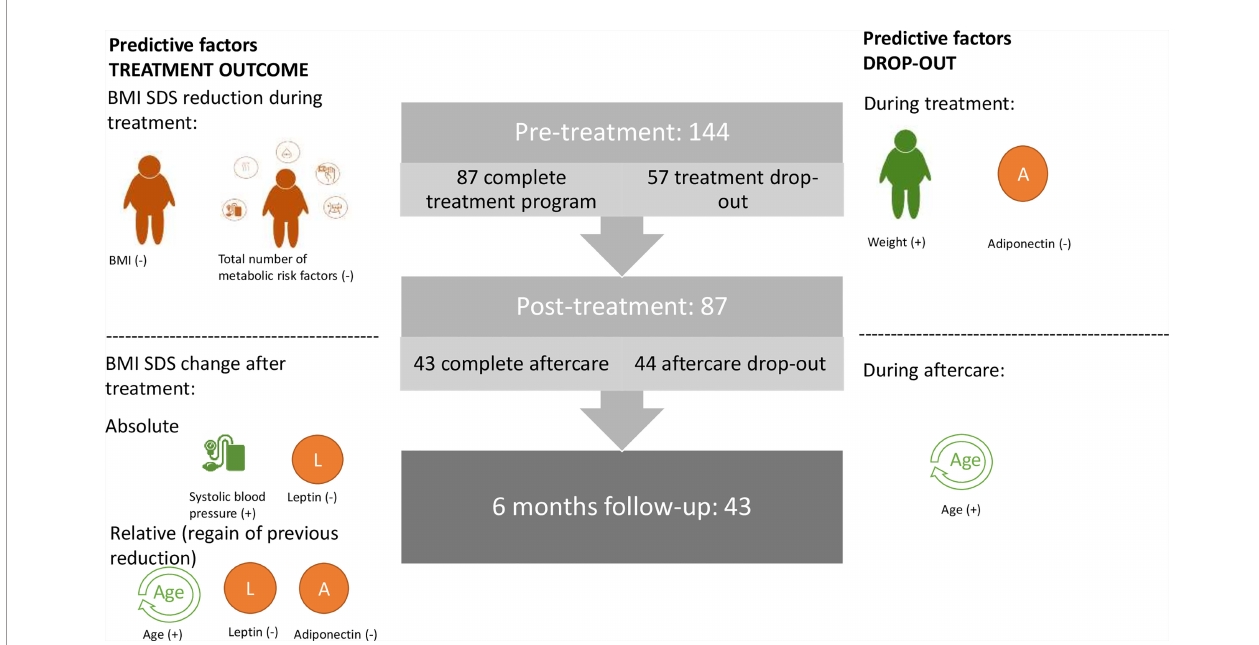
FIGURE 2 | Visual overview of factors predictive for dropout and treatment outcome.The middle panel represents the number of study patients at every visit. The left side depicts the factors predictive of the treatment outcomes. Pre-treatment BMI and total number of metabolic risk factors inversely affected the BMI SDS reduction during treatment. Post-treatment absolute BMI SDS change was predicted by systolic blood pressure (+), expressed as Z-score and baseline leptin (-), whereas post-treatment BMI SDS regain was predicted by age (+), leptin (-), and adiponectin (-). On the right side, factors predictive of dropout during and after treatment were identi fi ed. During treatment, higher weight and lower adiponectin levels were risk factors for premature treatment cessation, whereas during aftercare, only those at older age (which coincides with a higher BMI) were found to be at increased risk for dropout. + or – indicates whether the factor is positively or inversely predictive of the dependent variable, that is, treatment outcome or